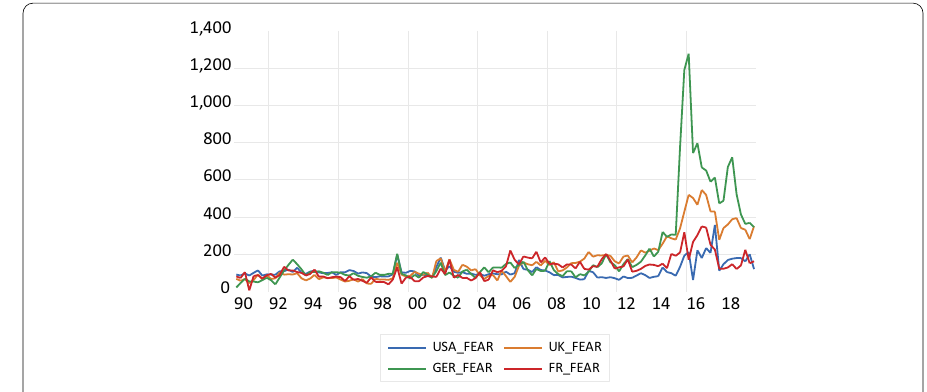
Fig. 1 Time series plots of FR-Fear, GER_Fear, UK_Fear and